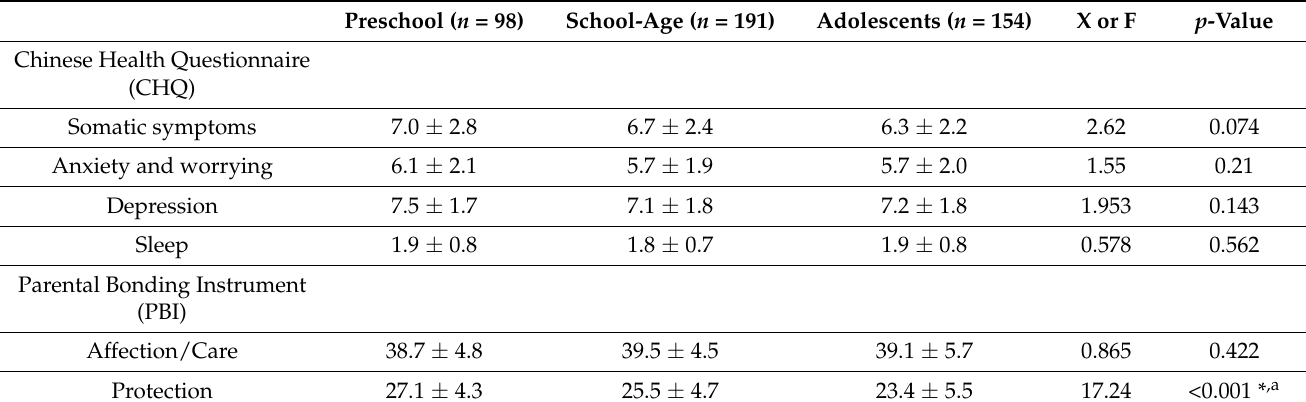
Table 4 lists the mental health and parenting styles of caregivers. Using CHQ (physical symptoms, anxiety and worry, depression, and sleep) to measure the mental health status of caregivers is comparable among the three age groups. In the parental bonding instrument (PBI), we found the protective parenting style ( p < 0.001) were significant differences among the three age groups. However, there were no significant differences in the perception of being affectionate and warm among groups. In the post hoc tests, we found the caregivers of preschool children showed higher protection tendencies than those of school-age children ( p = 0.008) and adolescents ( p < 0.001). In addition, caregivers of school-age children had a greater protective parenting style than those of adolescents ( p < 0.001). Table 4. The mental health and parenting style among the caregivers of preschool, school-aged and adolescents individuals.